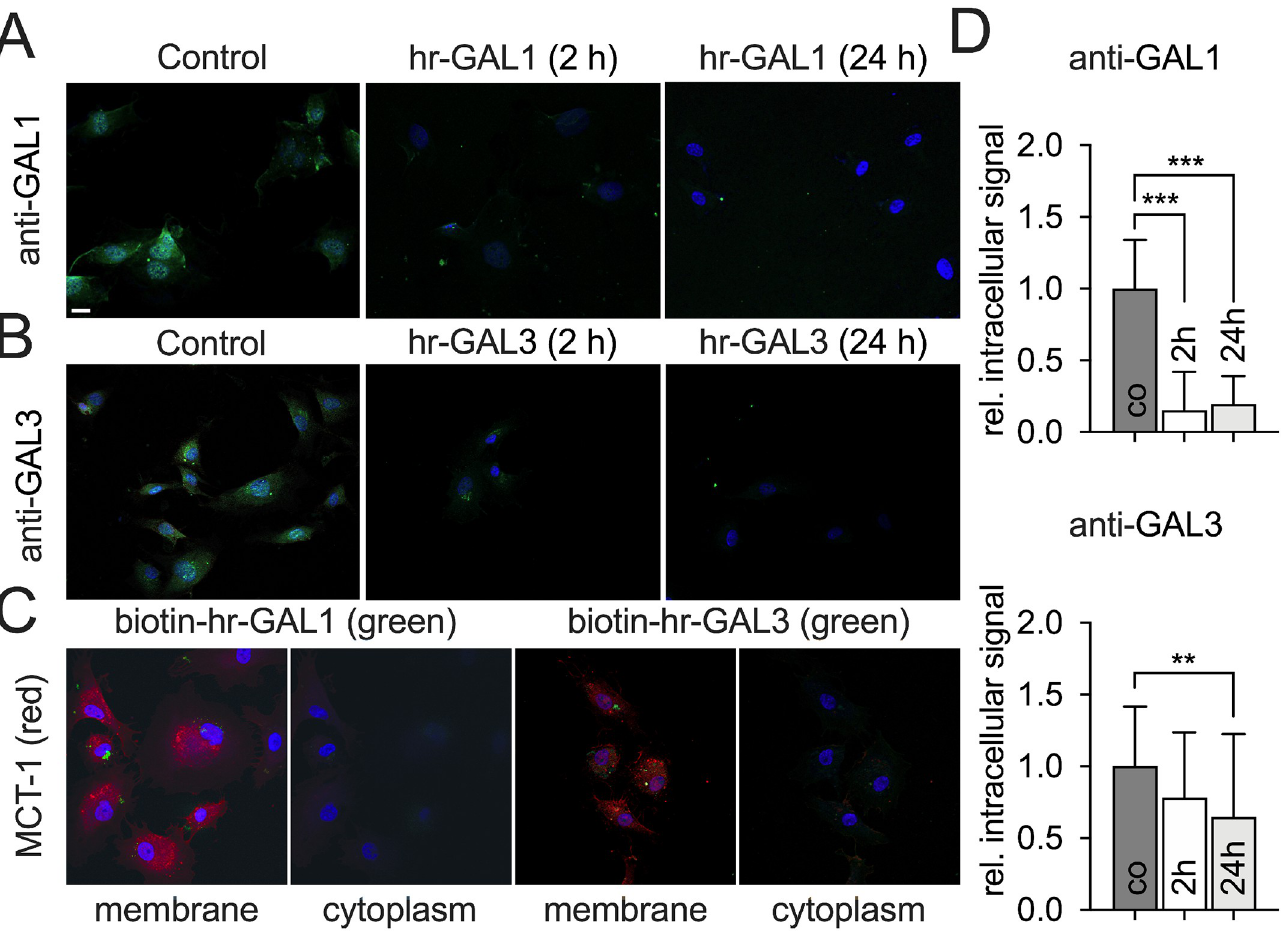
Fig 1. Localization of galectin-1 and -3 following incubation of HRMEC with hr-GAL1 and 3. Immunostaining of HRMEC for galectin-1 (A) and -3 (B) after incubation with 120 μ g/ml hr-GAL1 and 3 for 2 as well as 24 h. C. Detection of biotinylated hr-GAL1 and 3 (green) after incubation of HRMEC with 30 μ g/ml recombinant protein for 2 h and immunostaining for MCT-1 (red) as a marker for the cell membrane (C). Membrane, focal plane of the cell membrane; cytoplasm, focal plane of the cytoplasm; magnification bar in A–C, 20 μ m; blue, Hoechst staining. D. The intracellular fluorescent signal for galectin-1 or -3 of the control group and hr-GAL1 or 3 treated HRMEC was quantified, normalized against the control group and plotted as relative intracellular fluorescent signal. �� p < 0.01; ��� p < 0.001; n = 30 of 3 independent experiments.